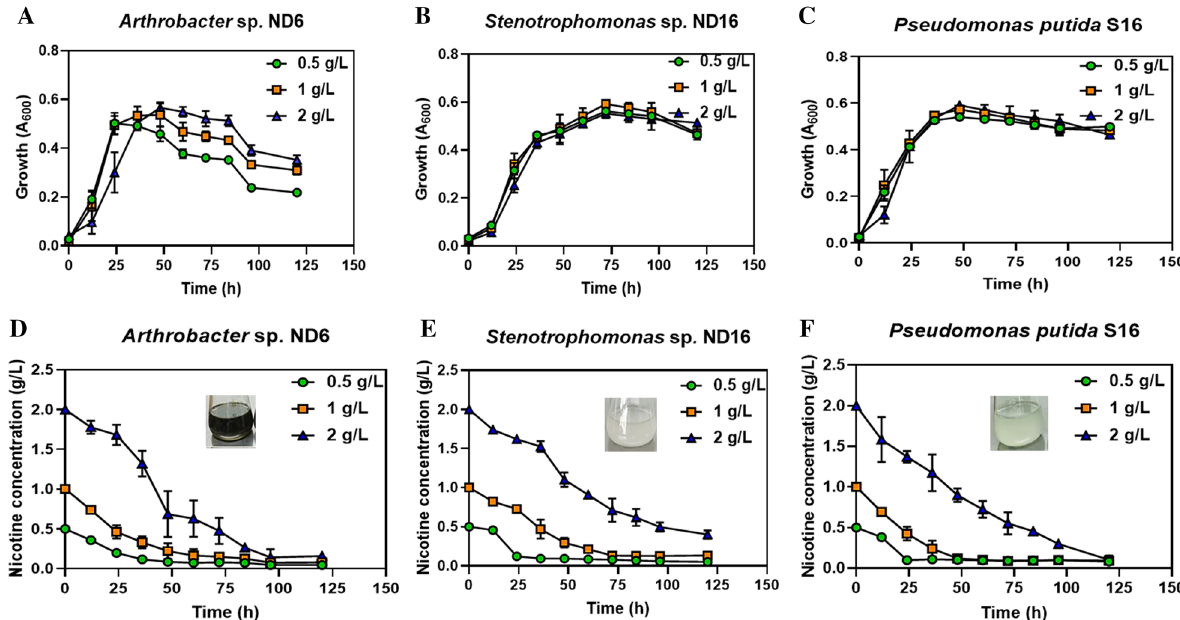
Fig. 5 Effects of nicotine concentrations on bacterial growth and nicotine degradation. A – C Growth curves of tree strains under different nicotine concentrations; D – F nicotine-degrading curves and colors of three strains under different nicotine concentrations